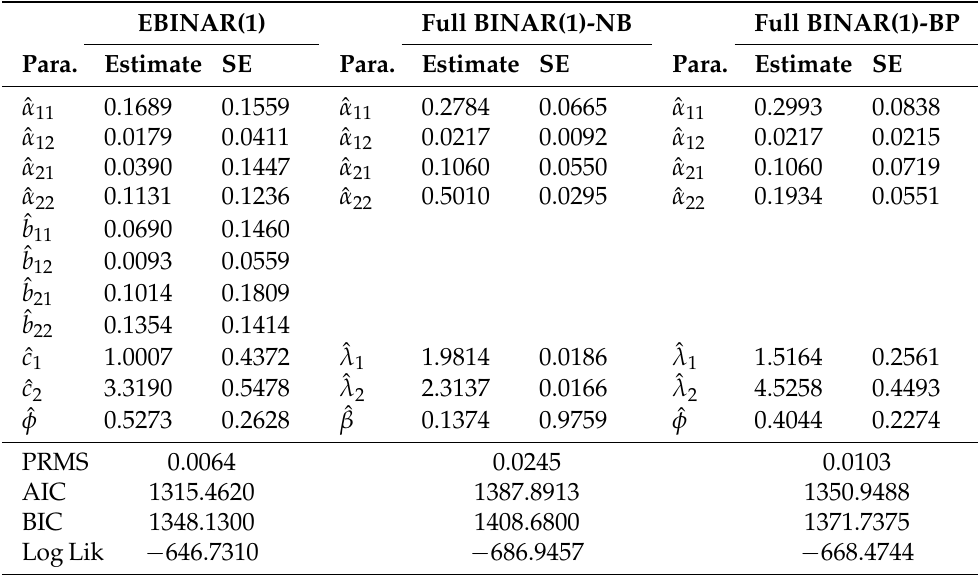
Table 7. Estimates for the monthly numbers of burglaries and those of CMIS in beat 11. EBINAR(1) Full BINAR(1)-NB Full BINAR(1)-BP